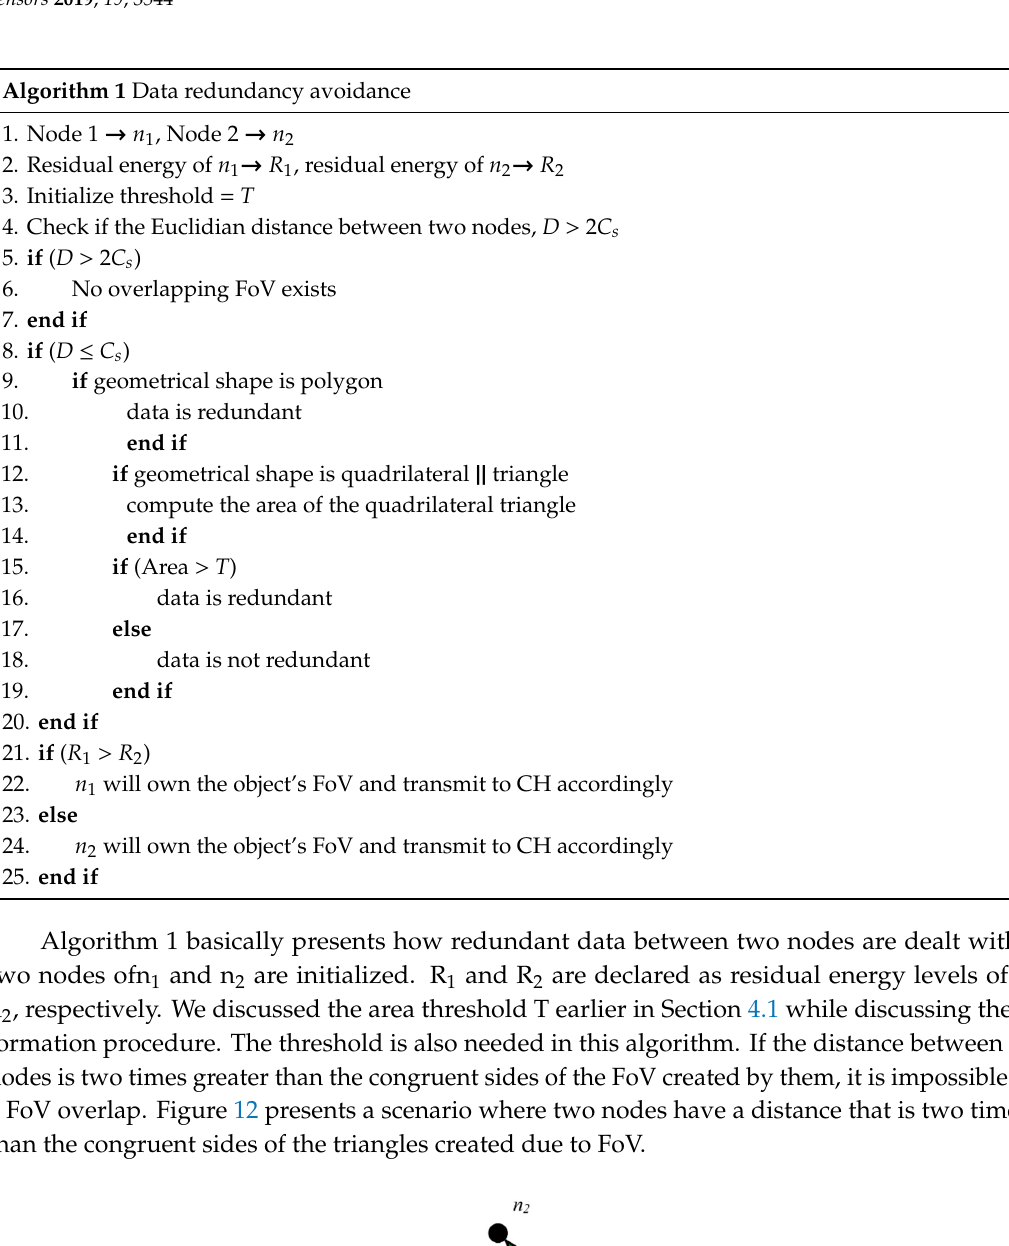
Figure 14. Overall process for routing in the proposed EGR. Cluster formation Election of CH nodes using game theory